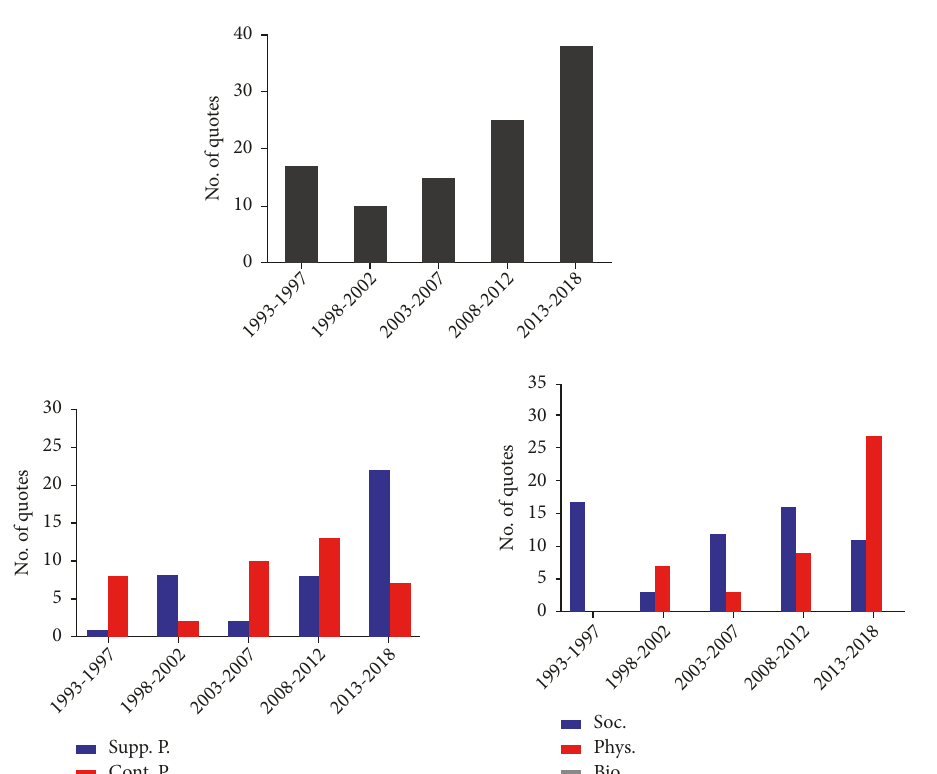
Figure 2: Visualising temporal analyses on quotes that include the term panic. The column chart on the top represents the total number of quotes and the one in the bottom splits the frequency based on whether the quotes support or contradict the theory (chart on the left) and based on the study discipline (chart on the right). To account for the fact that the last time interval includes 6 years as opposed to the rest of the time intervals that include 5 years, the numbers associated with the last interval have been scaled down by a factor of 5/6. The very few studies covered by this review and published prior to 1993 or in 2019 we accommodated in the first and last intervals,